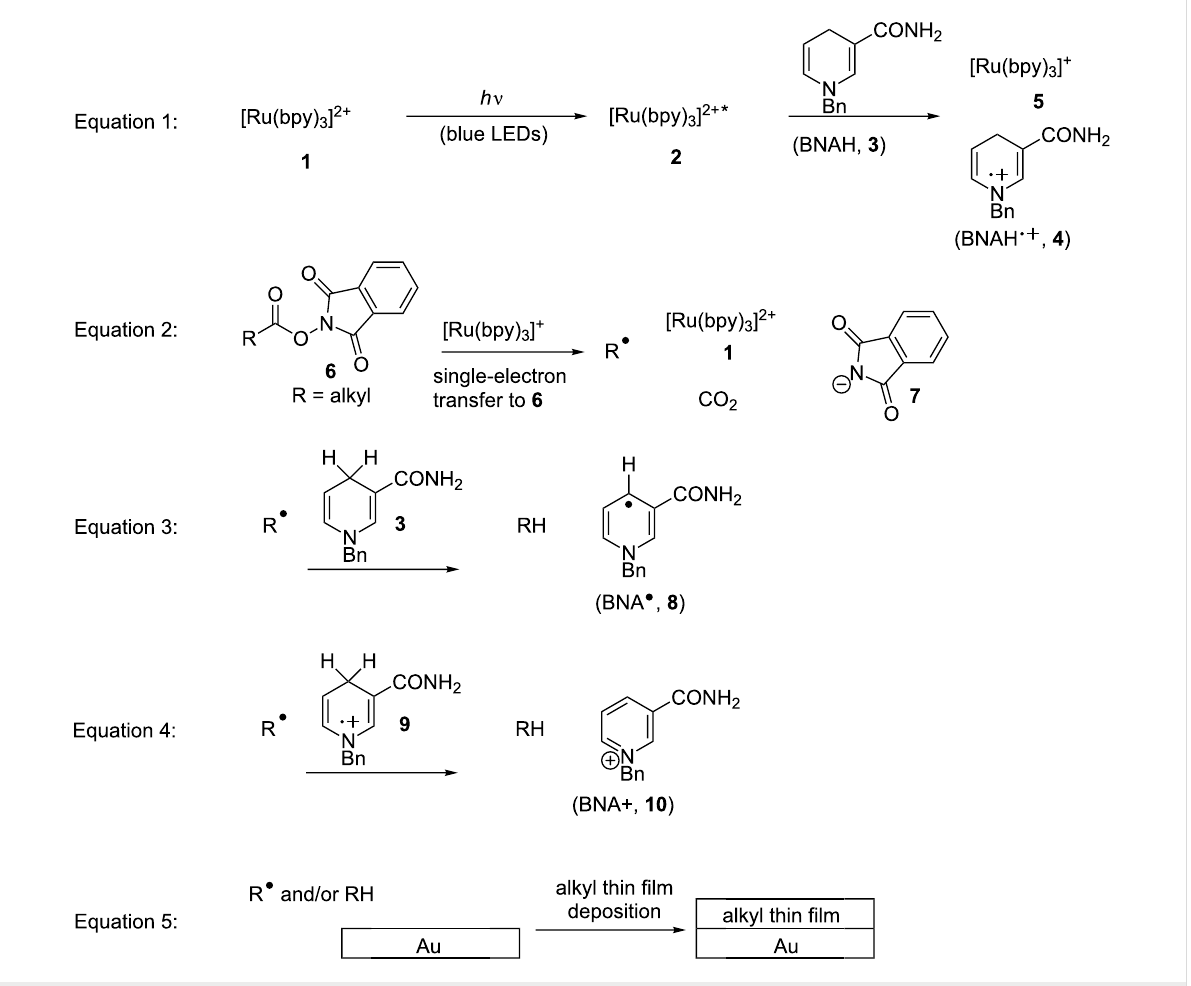
Scheme 1: Proposed visible-light-promoted thin film deposition on Au